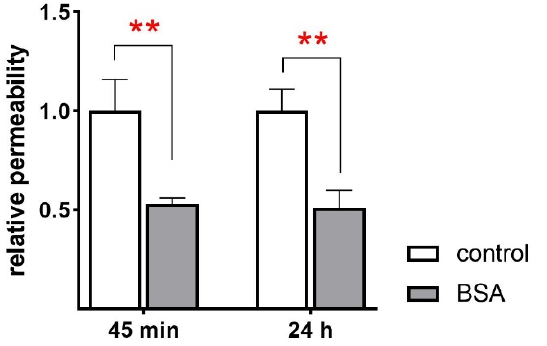
Figure 6. BSA decreases membrane permeability. FDLE cells were cultured in MEM and stimulated with BSA (1.0 g/L) for 45 min and 24 h. Data are displayed as mean + SEM normalized to control values. BSA significantly decreased membrane permeability (n = 11–12; ** p < 0.01 by t -test).